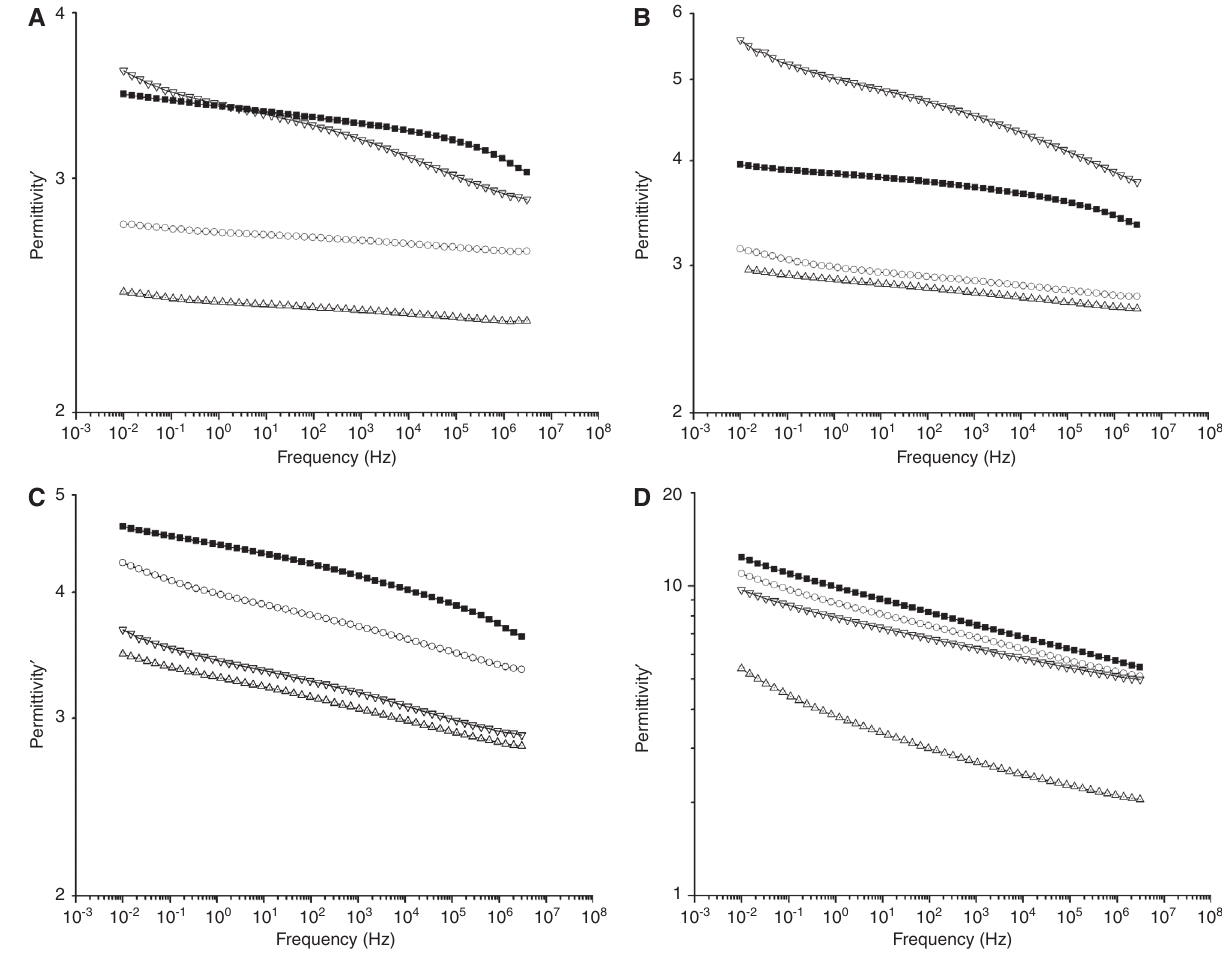
Figure 5 Dielectric permittivity at 30 ° C related to the frequency. (A) Compound+5% GTR, (B) compound+10% GTR, (C) compound+20% GTR, and (D) compound+50% GTR: ■, EVA; ○, HDPE; ∆, PP; ,